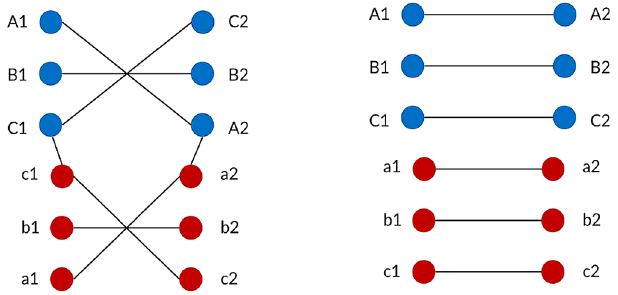
Figure 5. Quadruple circuit phase configuration for standard transposed phasing (left) and un-transposed phasing (right).